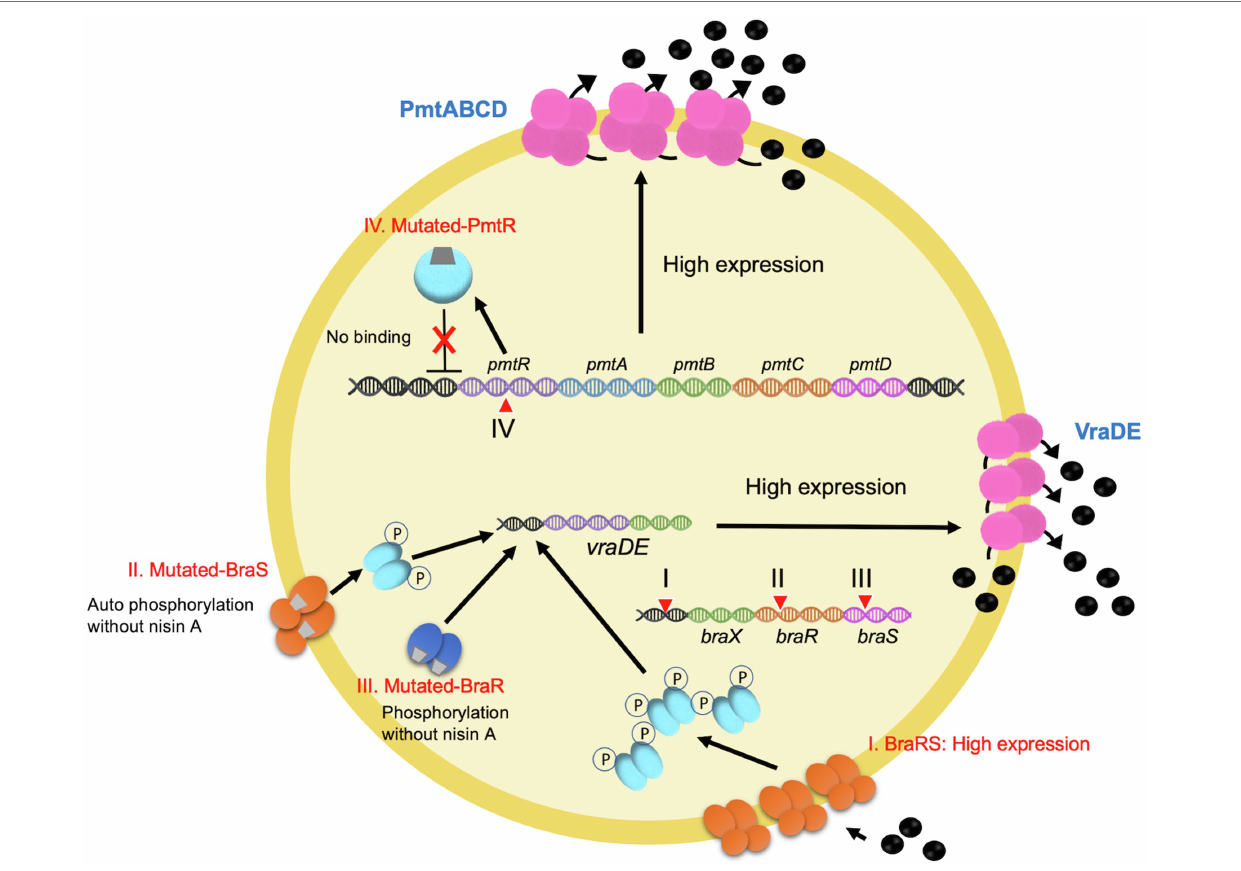
FIGURE 6 | Schematic diagram of the nisin A highly resistant mechanism. I. A point mutation in the promoter region results in the higher expression of braXRS . This leads to the increased induction of vraDE expression by nisin A. II. A point mutation in braS (encoding a sensor protein) causes nisin A-independent phosphorylation of BraS, resulting in increased phosphorylated BraR, which induces a constant expression of vraDE . III. A point mutation in braR (encoding a response regulator) results in nisin A-independent activation of vraDE expression. IV. A point mutation in pmtR encoding a negative regulator PmtR for pmtABCD expression. Mutated PmtR, which lacks the DNA binding ability, results in a constant pmtABCD